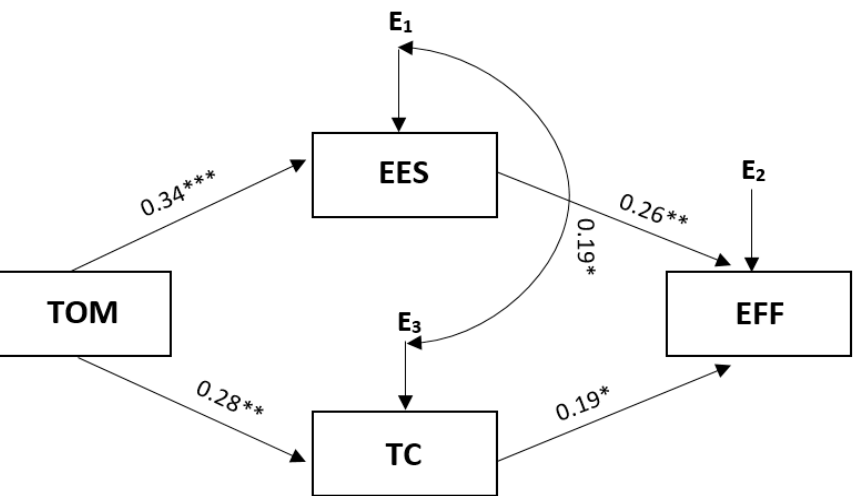
Figure 2. The summarising model of task orientation for strategy of coping with stress. Note. Chi 2 = 0.465; df = 1; p = 0.495; CFI model = 1.00; RMSEA = 0.00; indirect effect for task-oriented motivation = 0.143; 95% CI [0.061;0.247]. Coefficients: effectiveness R 2 = 0.13; EES R 2 = 0.12; TCS R 2 = 0.08; EES—effort expenditure strategies; TC—thought control; EFF—effectiveness of performance; TOM—task-oriented motivation. * p < 0.05; ** p < 0.01; *** p < 0.001.